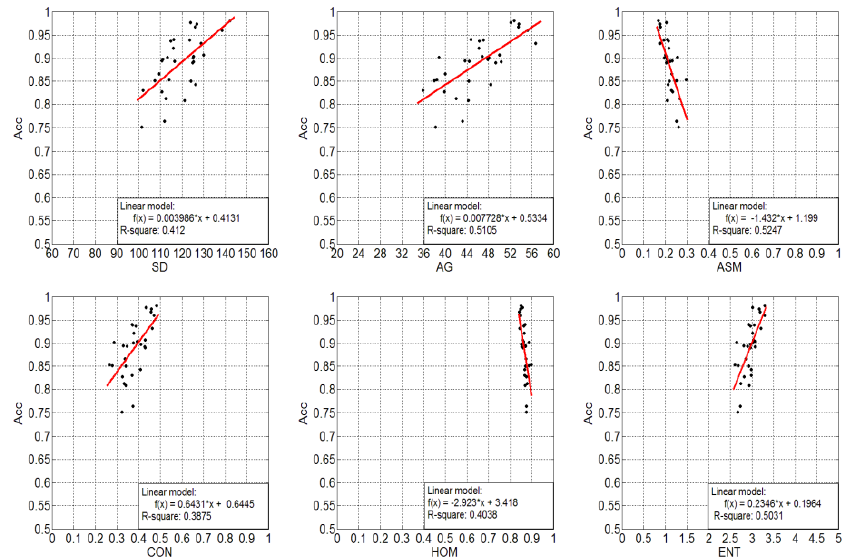
Figure 6. The relationship between the quality index of images in urban area and classification accuracy in the same classification system.